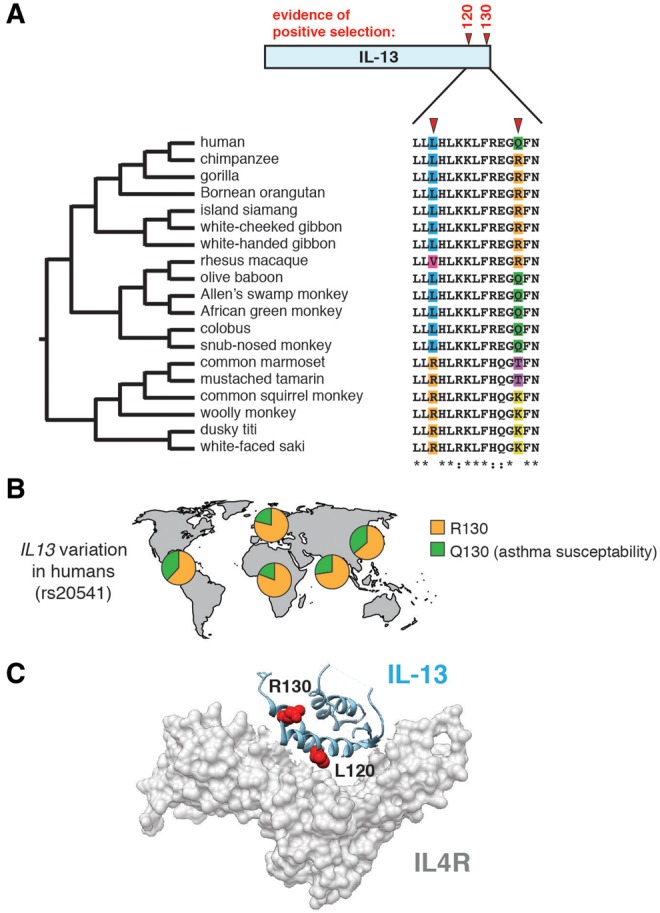
—Variation in interleukin 13 among primates associated with human asthma susceptibility. (A) Analyses using PAML and the FUBAR algorithms narrowed signatures of selection in primate IL-13 to two amino acid positions, 120 and 130. Amino acid variability at these sites across 19 primate species is highlighted. (B) Schematic depicting allele frequencies for IL13 R130 and Q130 variants across human populations. Individuals carrying the Q130 allele have previously been shown to have increased asthma susceptibility. Data from the 1000 Genomes Project (phase 3). (C) Co-crystal structure (PDB: 3BPO) of IL-13 (blue) in complex with its receptor, IL4R (gray). Side-chains of amino acids subject to positive selection across primates are highlighted in red.